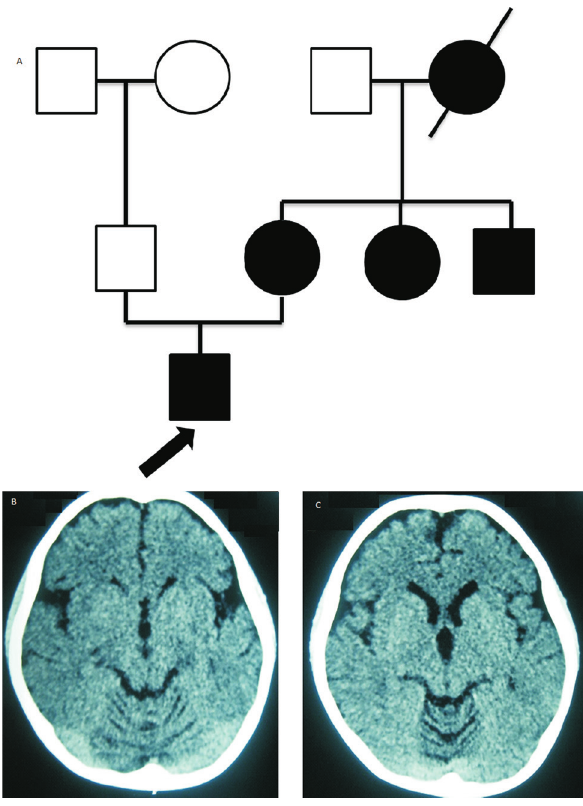
Figure 1 - A. Pedigree, arrow: the propositus. B-C ., Propositus’ CT brain scan showing mild pontine atrophy and moderate cerebellar atrophy